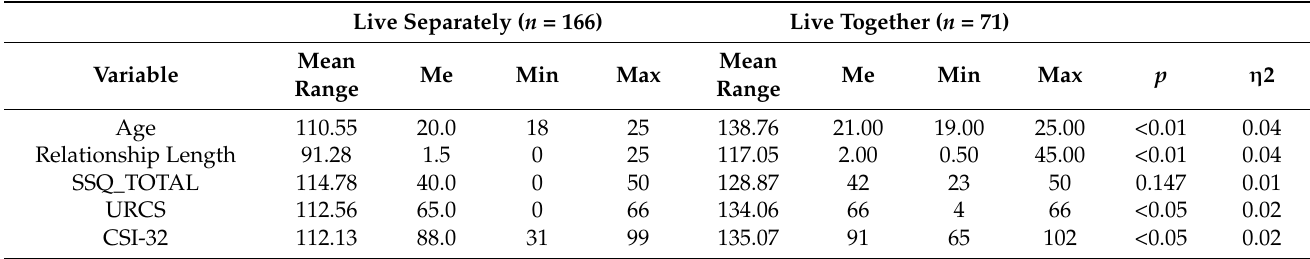
Table 4. Differences in psychological factors in people living together or separately.